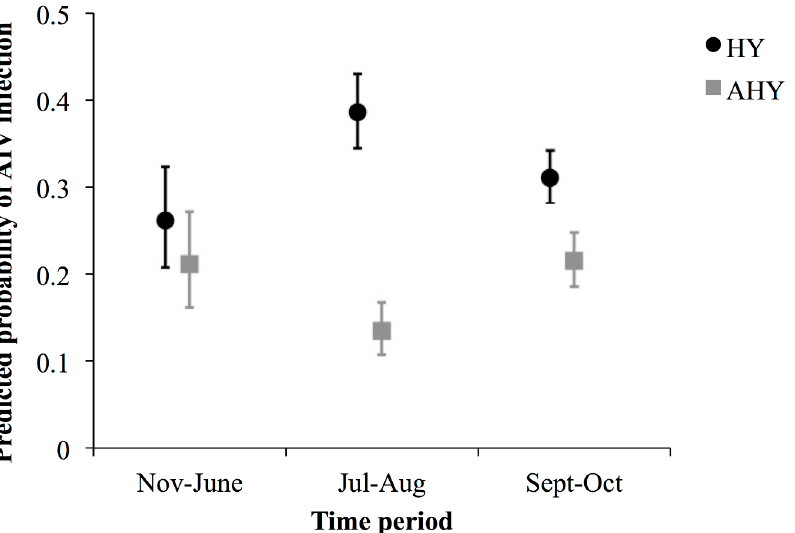
Fig 3. Predicted probability of avian influenza virus (AIV) infection in Blue-winged Teal, illustrating the interaction between age and season. Predictions are based on the best-supported model (Table 3) with other explanatory variables set at male (Sex), 2010 (Year), central flyway (Flyway) and mean latitude. Hatch year: HY, after hatch year: AHY. Error bars represent 95% confidence intervals, based on SE calculated by the delta